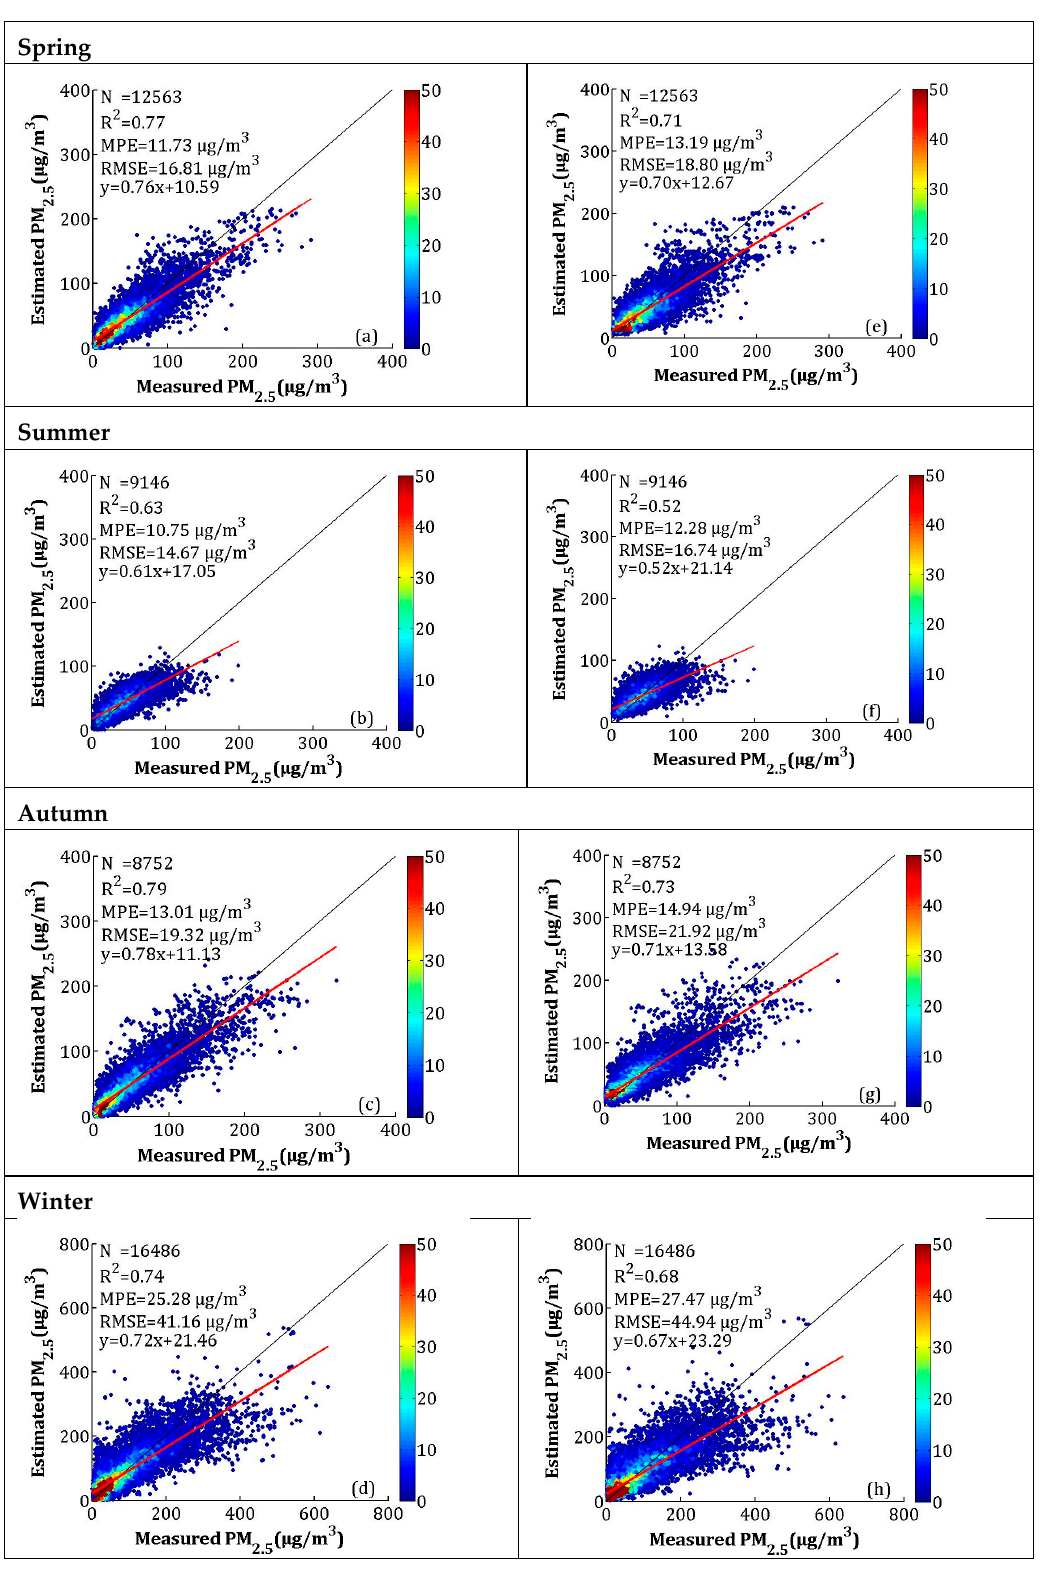
LME model fitting results, and ( b ) the cross-validation results. The dark solid line represents the 1:1 line, and the red solid line represents the regression line.